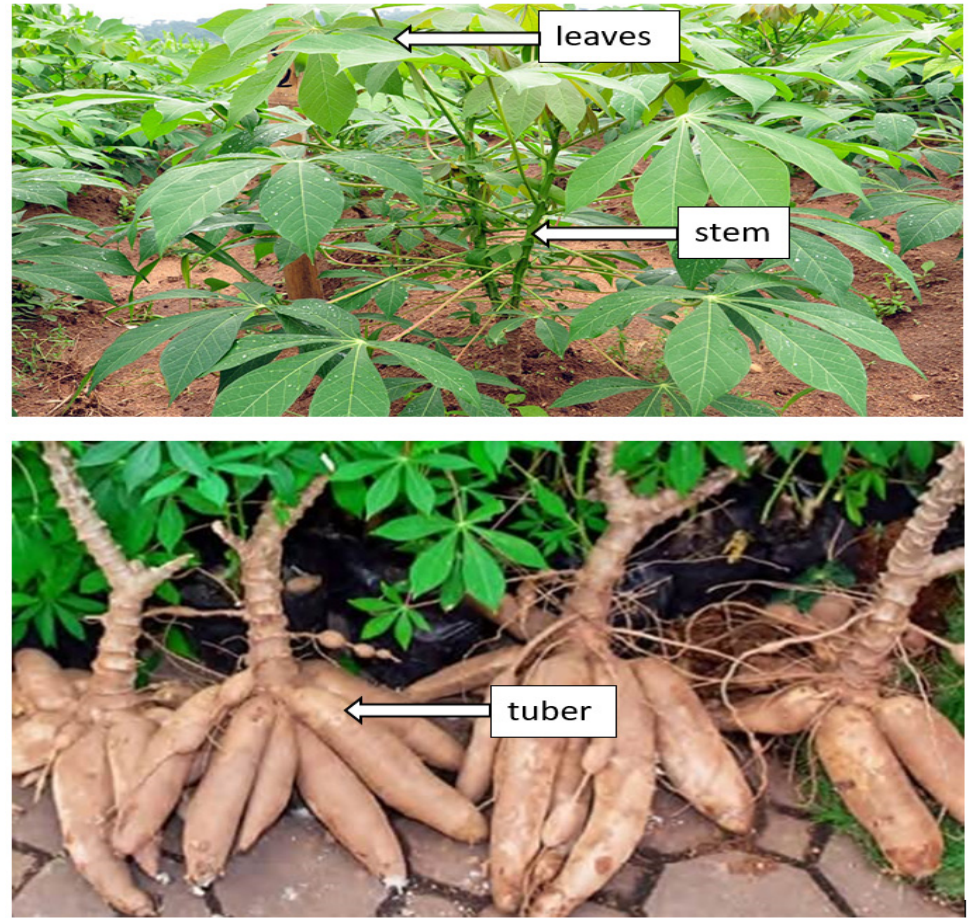
Figure 3. Cassava plant parts ( Manihot esculenta Crantz ). Leaf. This part contains starch and protein, the main building blocks for the cells’ growth and development. Hence, the yields are highly influenced by how stable the leaves are. According to Latif and Müller [98], the major diseases affecting the cassava plant ( Manihot esculenta Cranz ) in Africa are Cassava Brown Streak Disease (CBSD), Cassava Mosaic Disease (CMD), Cassava Bacterial Blight (CBB), and Cassava Green Mite (CGM). Stem. This cassava plant part functions as transport organ by transporting the produced food from leaves to different plant parts for their growth and development. Cassava reproduces via stem cutting; hence, the stem represents a new tool to expand the production of food and fuel materials [99]. Root. Cassava plants are composed of three root types: thick roots, fine white roots, as well as tuberous roots. The thicker roots act as anchors of the plant which grow underground, whereas the tuberous roots collect carbohydrates. Conversely, the fine white roots absorb nutrients and water [100].